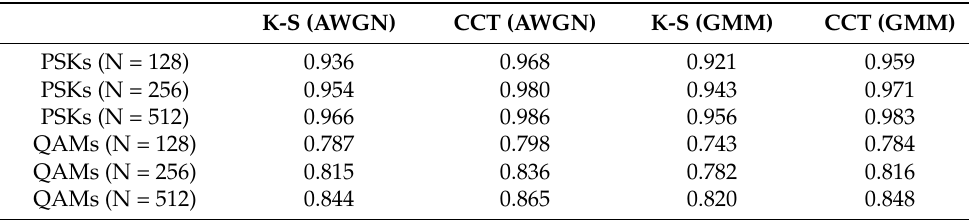
and non-Gaussian channel at N = 128, 256, and 512.